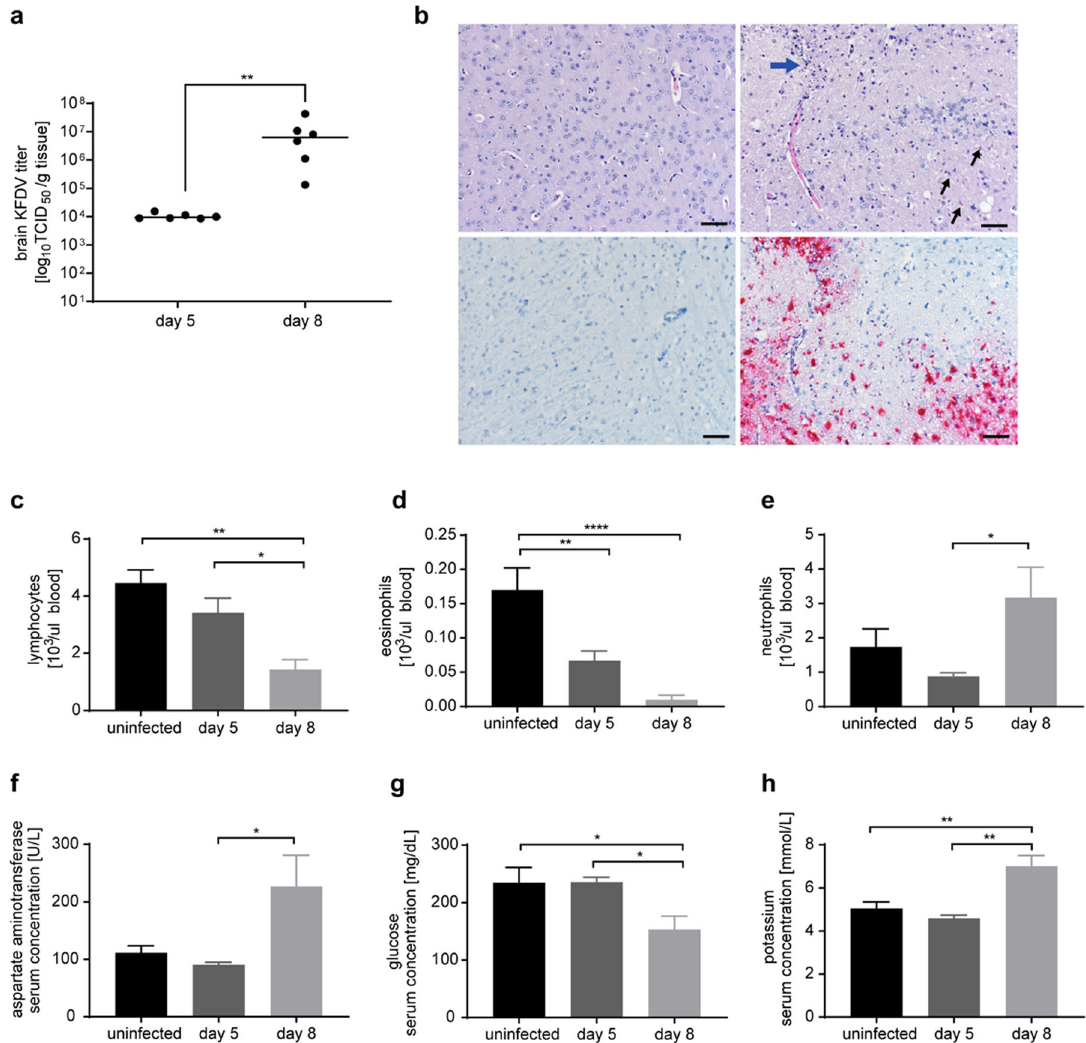
Fig. 3 KFDV pathogenesis in the mouse model. Female BALB/c mice ( n = 6 per group) were infected intraperitoneally with 1000 LD 50 (10 PFU) KFDV. Mice in the control group were inoculated with DMEM. Animals were sacri fi ced on 5 dpi and 8 dpi for organ harvest to determine virus load and analyze pathology. a KFDV load in brain tissue. b H&E stain and in situ hybridization of mouse brain tissue at 8 dpi (left, mock; right, KFDV). The H&E stain (upper panel) shows karyorrhectic debris (blue arrow) and neuronal necroses (small black arrows). The ( d ), neutrophils ( e ), aspartate aminotransferase ( f ), glucose ( g ), and potassium ( h ). Error bars represent the standard deviation. Statistical signi fi cance between mock (black) or KFDV infected mice (gray shades) was analyzed using unpaired T tests in Prism 7 (GraphPad) and